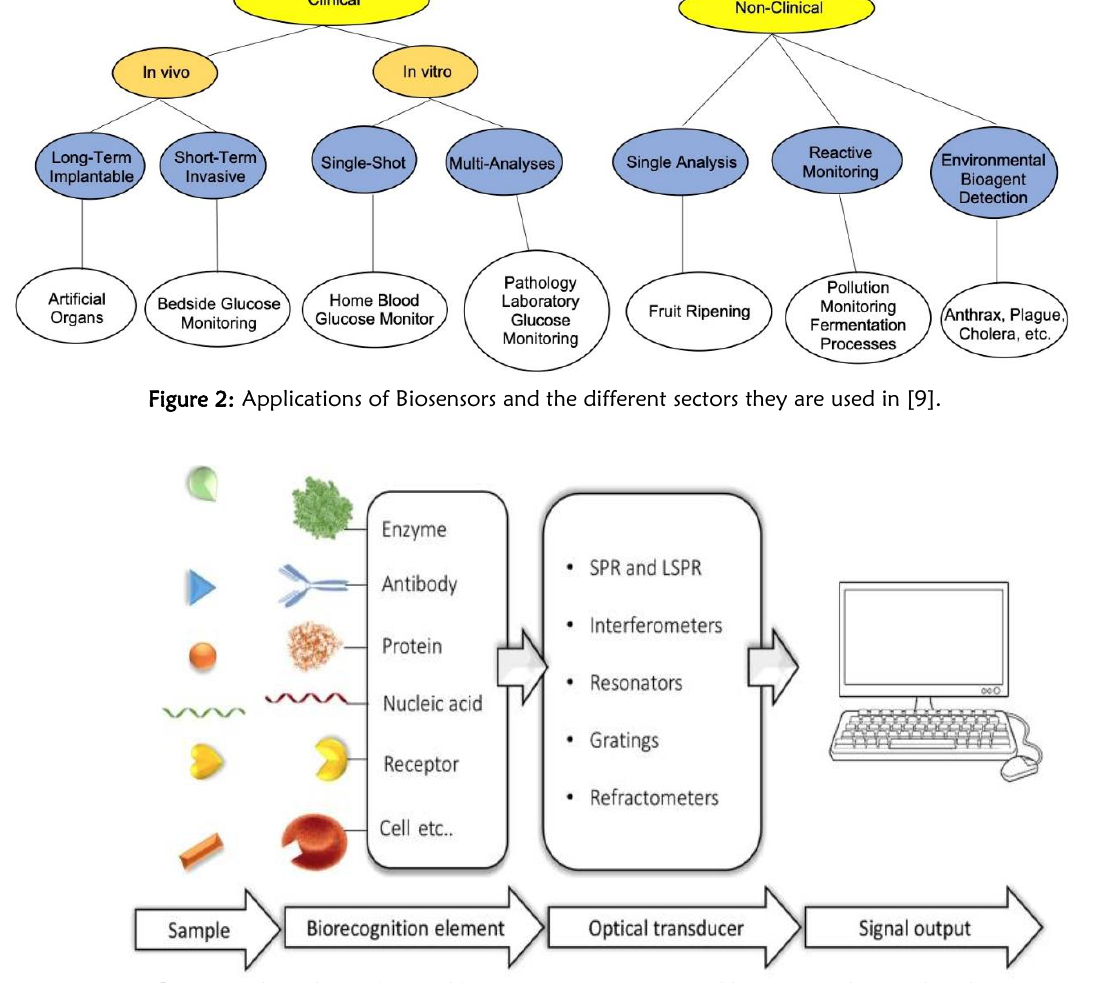
Figure 3: Flow chart of optical biosensor composition and how a signal is produced